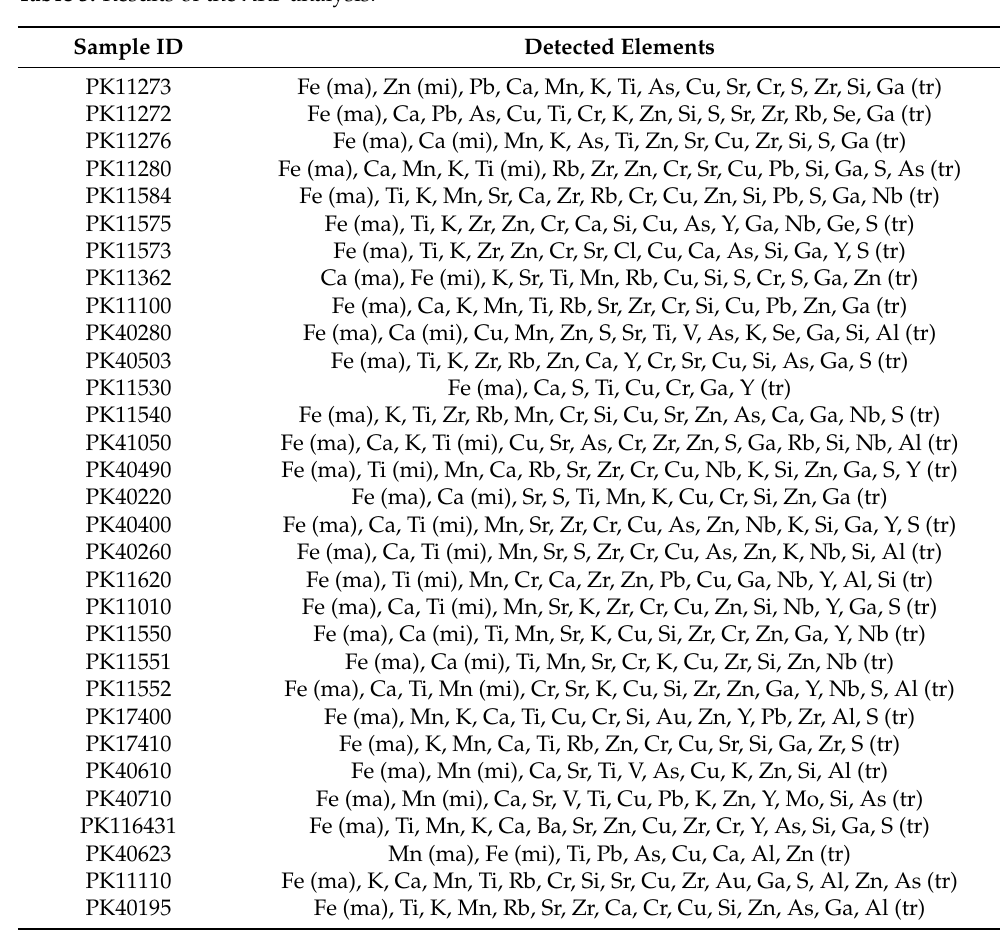
Table 3. Results of the XRF